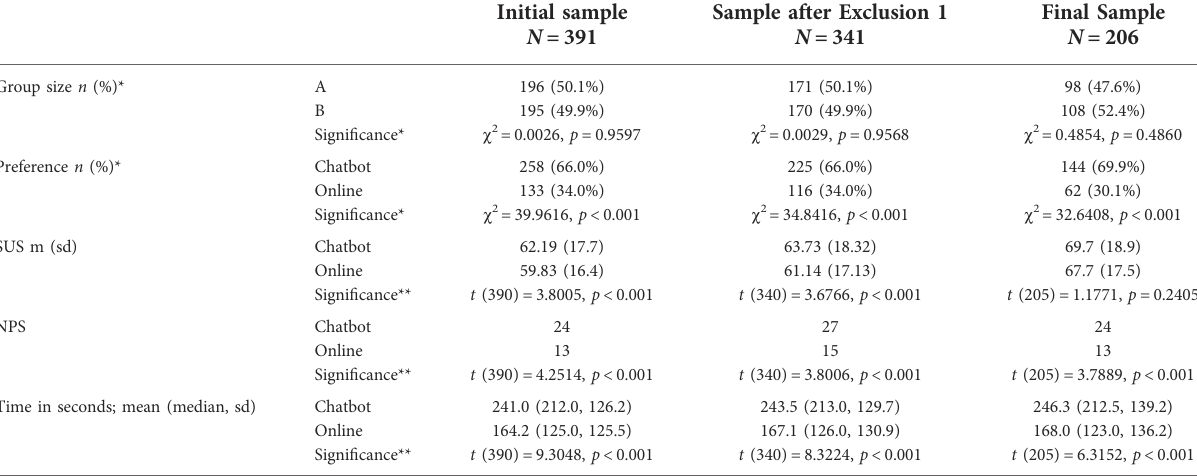
TABLE 4 Usability and preference characteristics at each